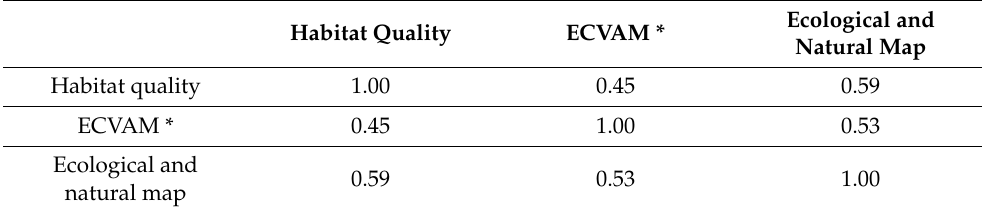
Ecological and Natural Map